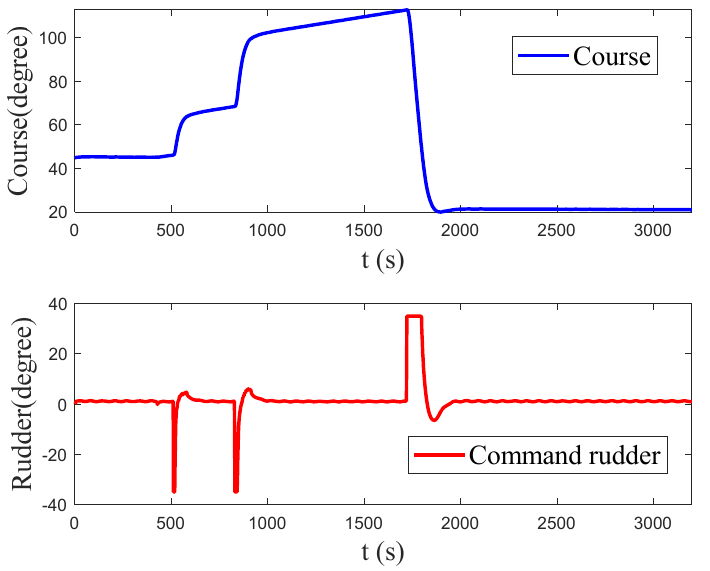
Figure 29. The course and rudder angle of ship–1 in scenario 3 under environment disturbance.